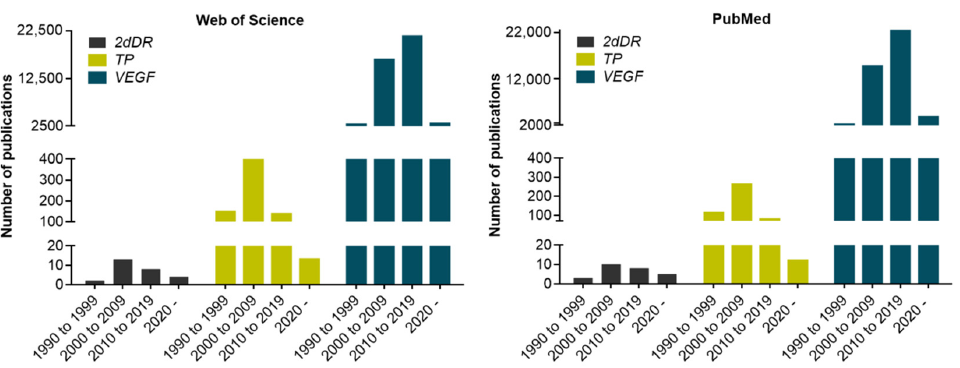
Figure 2. Distribution of angiogenesis-related publications using the WoS and PubMed databases on 2dDR, TP and VEGF from 1990 to date.